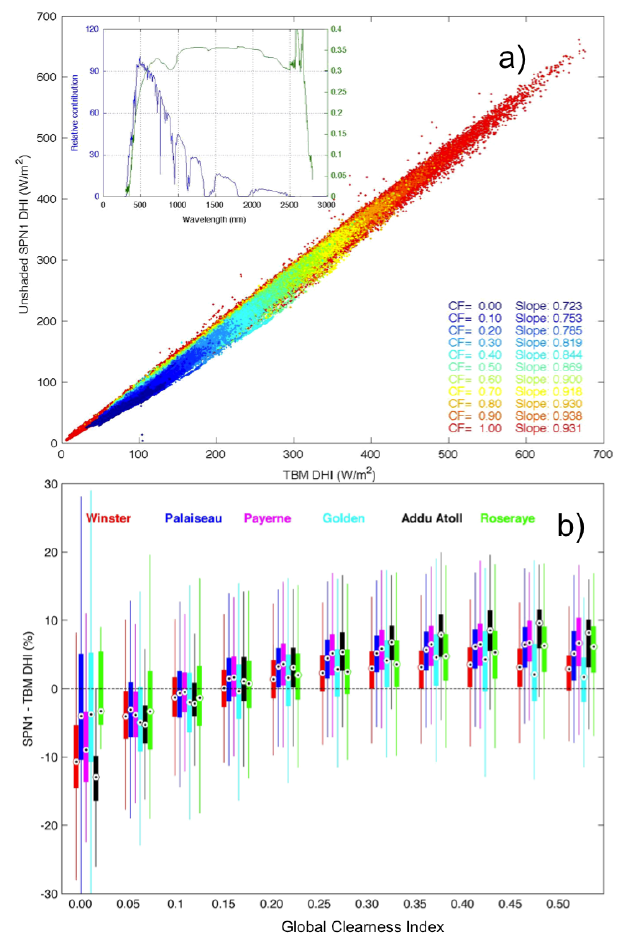
Figure 6. (a) Inner plot: Standard solar spectrum (AM 1.5) and SPN1 spectral response. Main plot: SPN1 (with no internal shadow mask) DHI vs. TBM DHI sorted by cloud fraction bins (in colour scale) at Winster. The regression slope values for each bin are shown on the bottom right corner. No calibration was applied to SPN1 data. (b) DHI differences vs. clearness index in box plots under sun- covered conditions (GHI equals DHI within 3%) at all sites. SPN1 values have been recalibrated as described in Sect. 4.2. Box size represents the percentiles 25 and 75. Whiskers account for 99.3% of data under Gaussian distribution